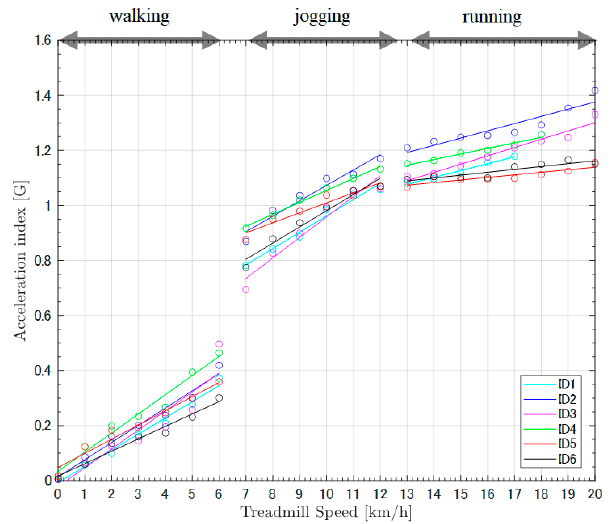
Figure 5. Regression lines of the acceleration index and treadmill speed comparison of all participants. All participants showed linear trends between acceleration index and treadmill speed within each condition: walking (0–6 km/h); jogging (7–12 km/h); and running (13–20 km/h).